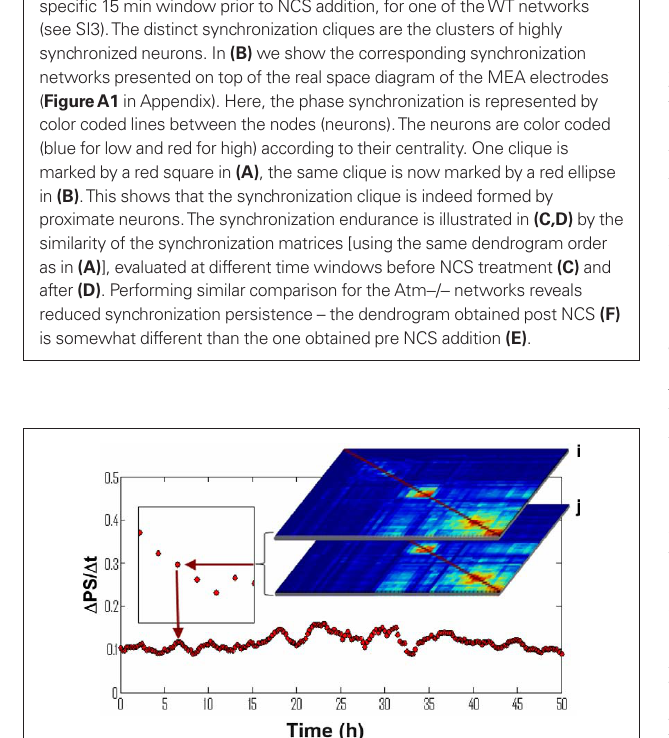
Figure 10 | Calculation of a synchronization persistence measure. For a PS matrix, m , representing the synchronization state of the network in 15 min snapshots, is subtracted from the next snapshot, n . All neuron pairs are summed and divided by the time period to yield a rate of synchronization changes.